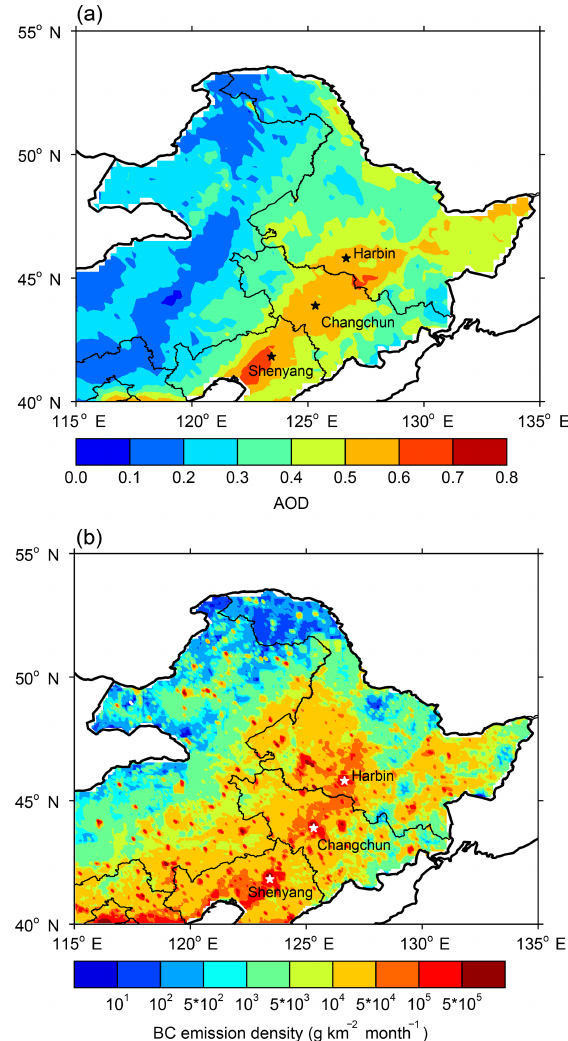
Figure 2. Spatial distribution of (a) MODIS AOD at 550nm and (b) BC emission density in January–February in NEC. AOD data are from 2003 to 2017, and BC emission density data are from the research group at Peking University (http://inventory.pku.edu. cn/home.html, last access: 15 June 2018) from 2003 to 2014. The major cities in NEC are also shown in this